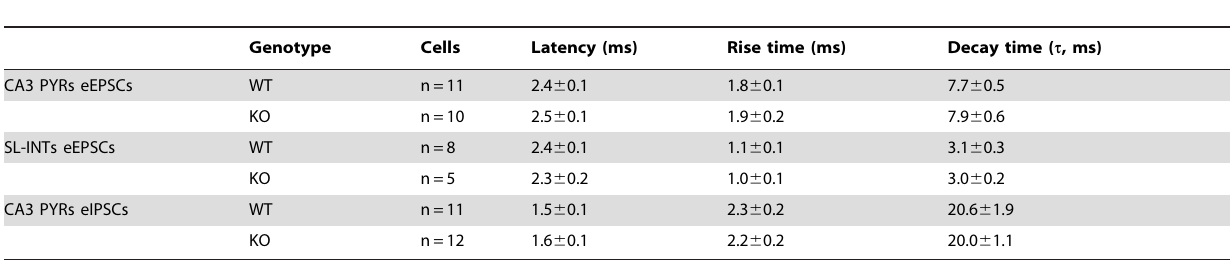
Table 1. The properties of evoked postsynaptic currents in CA3 area of BACE1 WT and KO